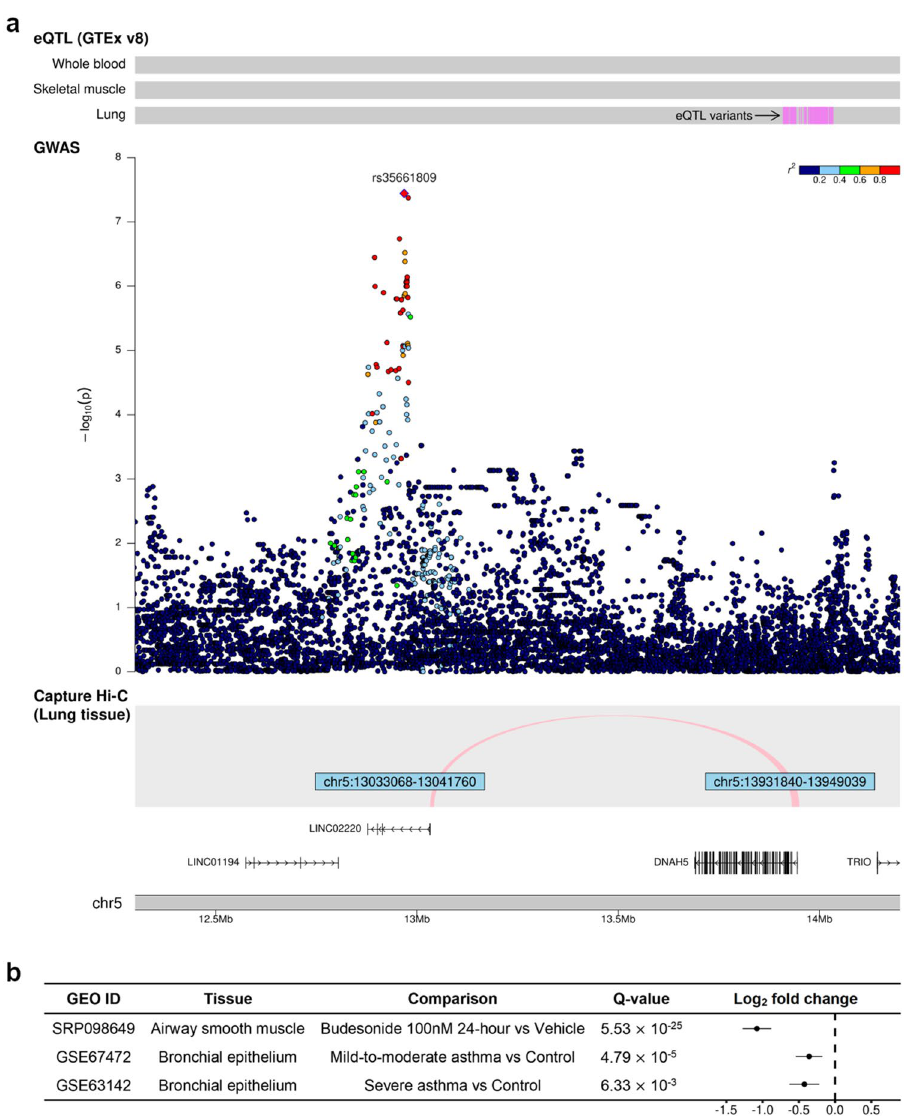
Figure 2. Evidence supporting DNAH5 as a BDR-associated gene in Puerto Ricans. ( a ) eQTL (top) from the GTEx v8 release, regional associations in the GWAS (middle), and a chromatin interaction in lung tissue (bottom) from the Capture Hi-C data. ( b ) differential expression results for DNAH5 using the GEO